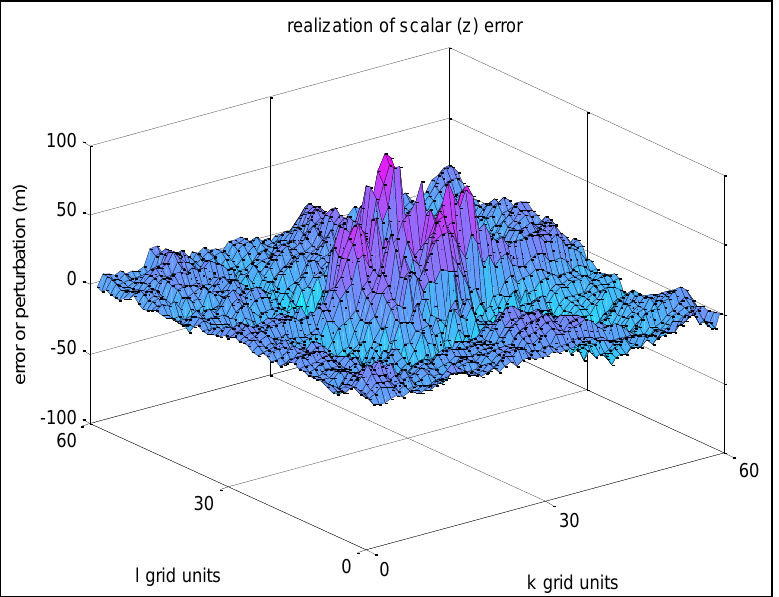
Figure 21. Non-homogeneous scalar realization—different variances and spatial correlations.